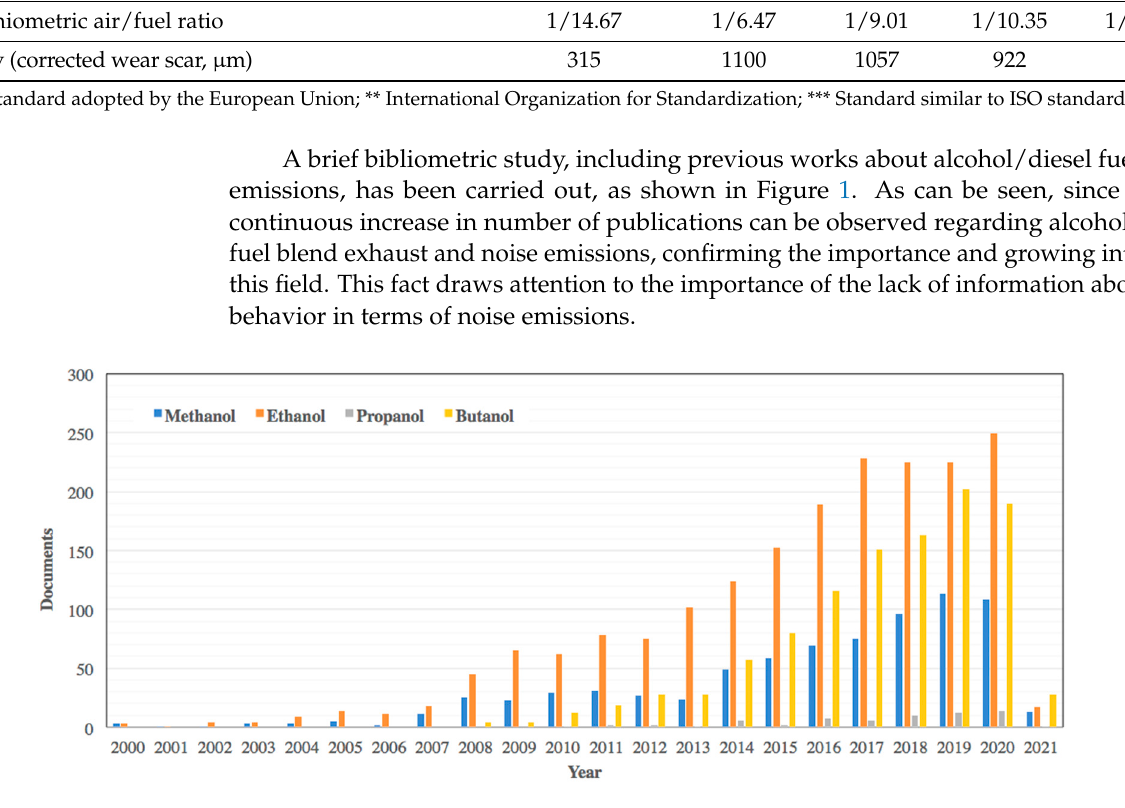
Figure 1. Number of published documents per year about alcohol/diesel fuel blends.